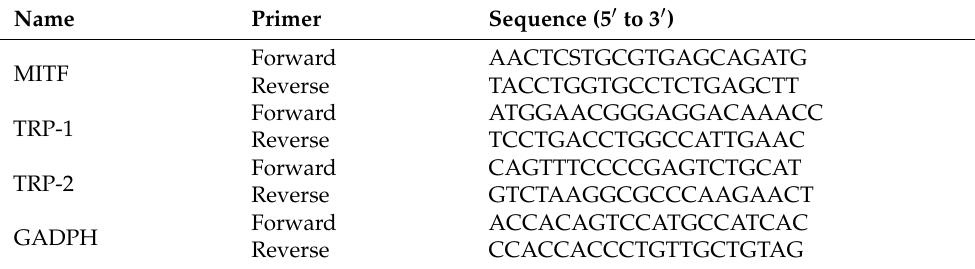
Table 2. Sequences of mouse primers used in the semi-quantitative